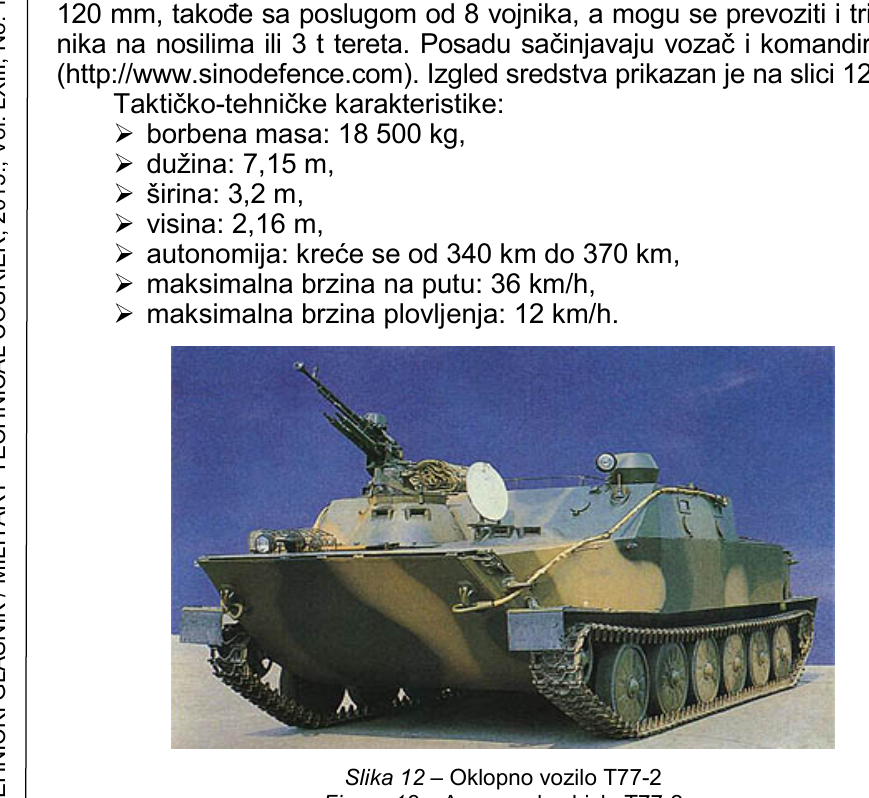
Vozilo BMD-2 namenjeno je za popunu vazdušnodesantnih jedinica i pomorske pešadije, za prevoženje i vo đ enje borbe u uslovima primene svih vrsta konvencionalnog i NHB oružja. Posadu č ini 7 č lanova: voza č , Vozilo je prikazano na slici